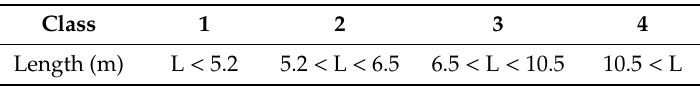
Table 2. Vehicle classification based on their length (L).